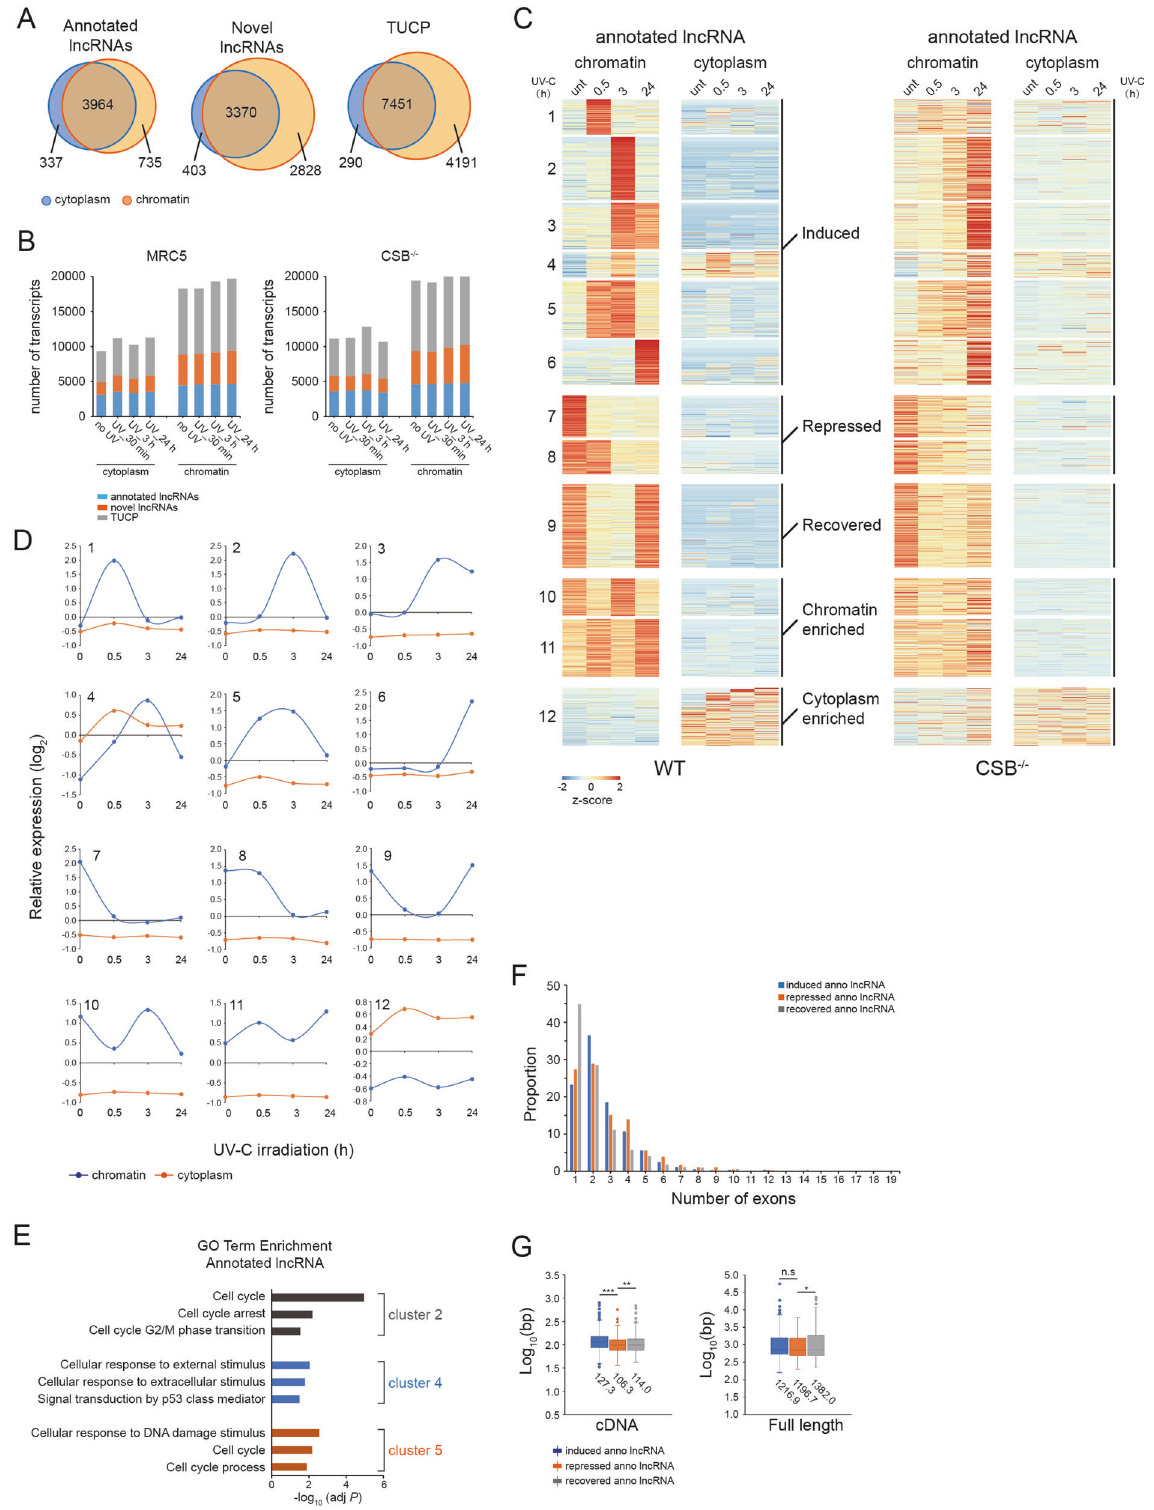
in regulating the balance between continuous loads of fresh RNAP II and degradation of arrested RNAP II? New tools to map sites of DNA damage and its repair for the entire genome at single- nucleotide resolution have been developed within the recent fi ve years [26, 27]. DNA repair-related XR-seq combined with